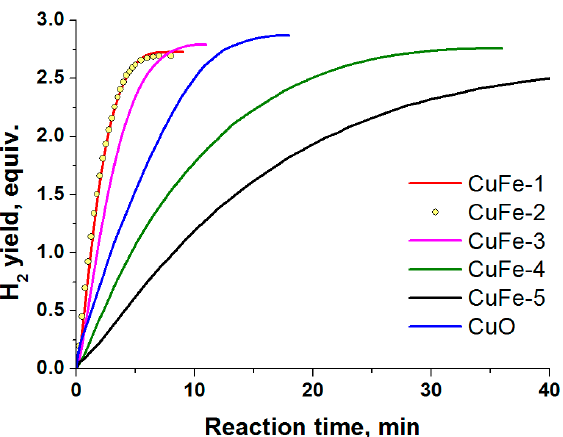
Figure 6. The activity of CuFe-combustion products (Table 2) in the catalytic hydrolysis of NH 3 BH 3 (0.123 М ) at 60 ° C.